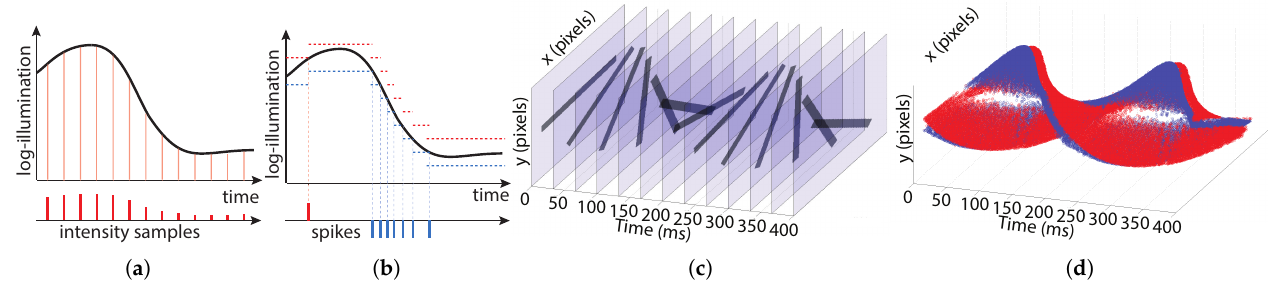
Figure 1. Comparison between frame-based and event-based vision sensor principles. ( a ) Sampling of a frame-pixel occurs at constant time intervals. ( b ) Sampling of an event pixel occurs whenever the log-intensity change exceeds a threshold. The ON and OFF thresholds are represented with red and blue dotted lines, respectively, and updated at each event. ( c ) Example of 24 fps frame-data (simulated) that would be generated by a rotating bar. ( d ) Example of event data gathered when viewing the same rotating bar (actual recording). Red and blue dots show the ON and OFF events capturing the contrast of the bar’s edges relative to the background according to